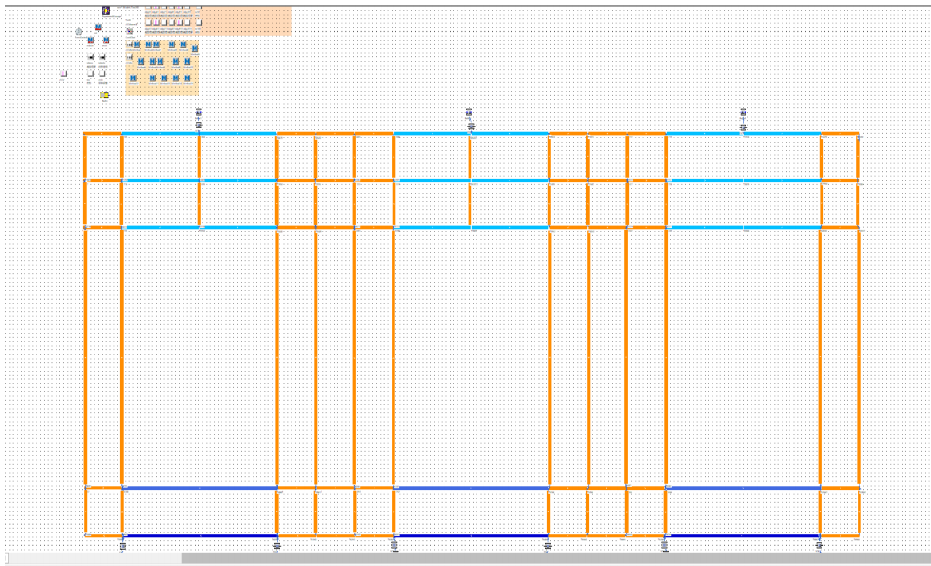
Figure 7. Simulation model layout diagram.